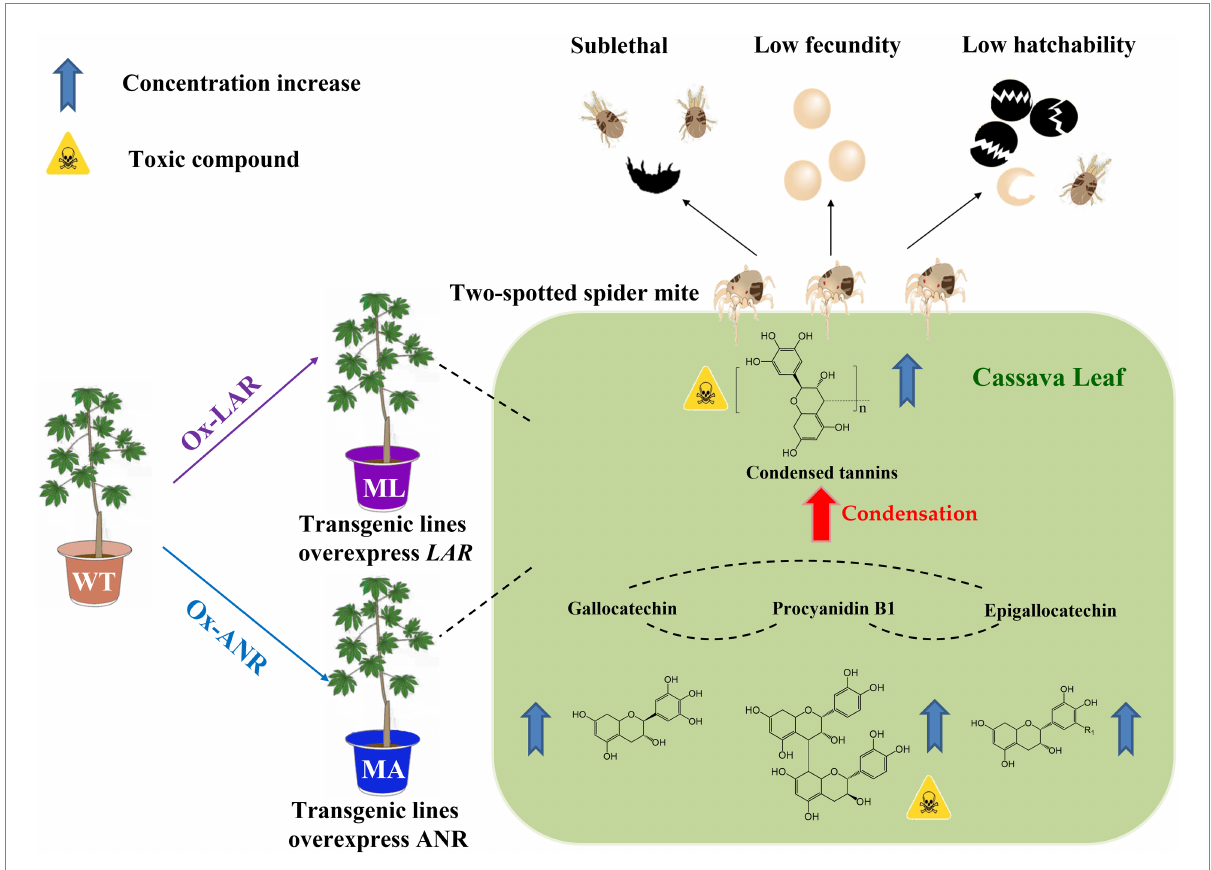
FIGURE 6 Summary of the dissection of candidate TSSM resistant genes MeLAR and MeANR and validation of their role in overproducing tannins and confers cassava resistance to